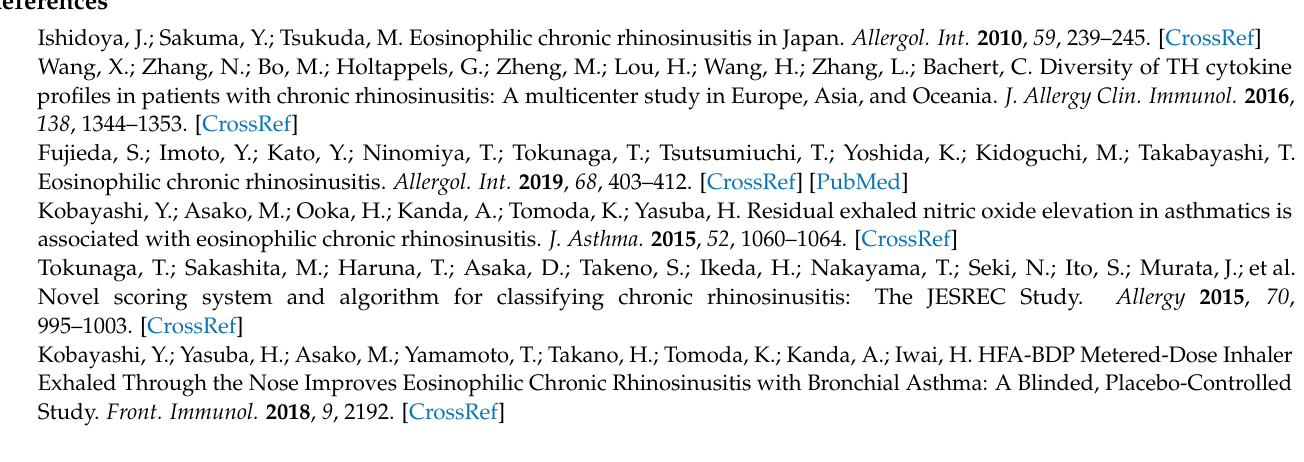
sinusitis. Figure S2: CD69 expression on human eosinophils. Figure S3: Effects of omalizumab on indicators of type 2 inflammation. Table S1: Amplification